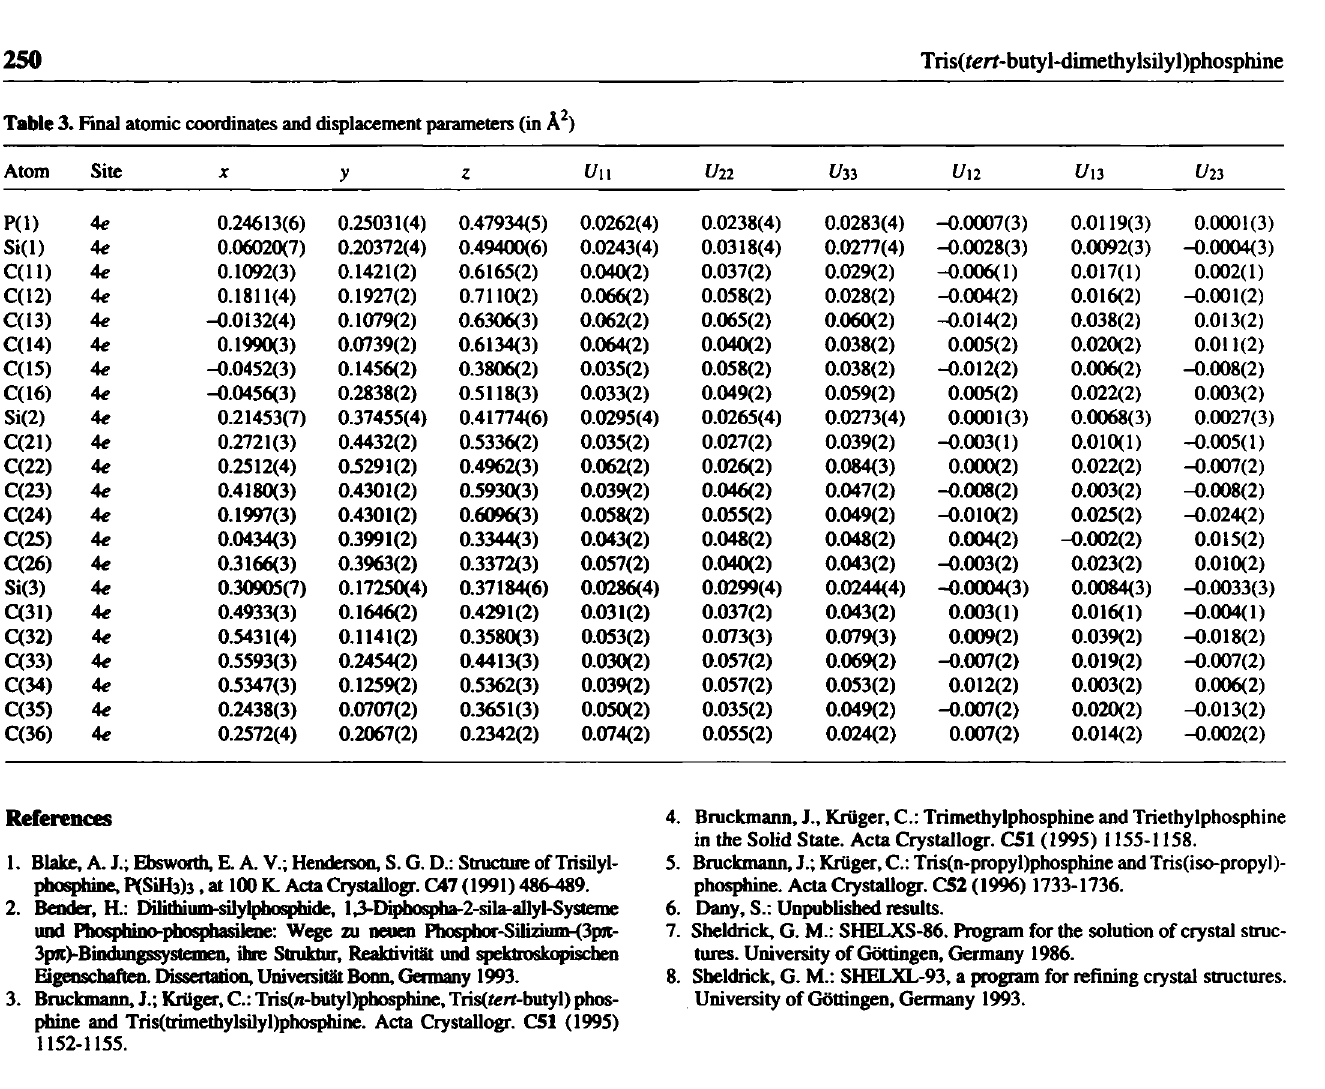
Table 3. Final atomic coordinates and displacement parameters (in À 2